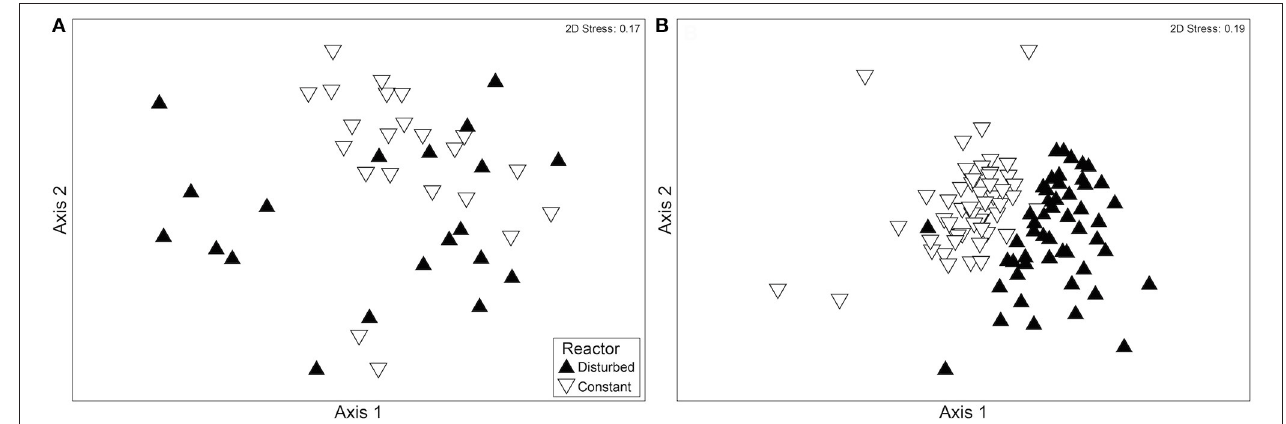
FIGURE 3 | MDS plots showing a comparison of the bacterial communities of the disturbed and constant reactors (A) before and (B) after the beginning of Phase III, with its fluctuating water level in reactor D. Each point represents a community sample with multiple OTUs present in ARISA. The samples in (A) were collected during Phases I and II (between November 5, 2010 and April 9, 2012), and the samples in (B) were collected during Phase III (between April 16, 2012 and November 8, 2012). Both figures include communities experiencing low water level and high water level. The samples are categorized according to the reactor of origin.